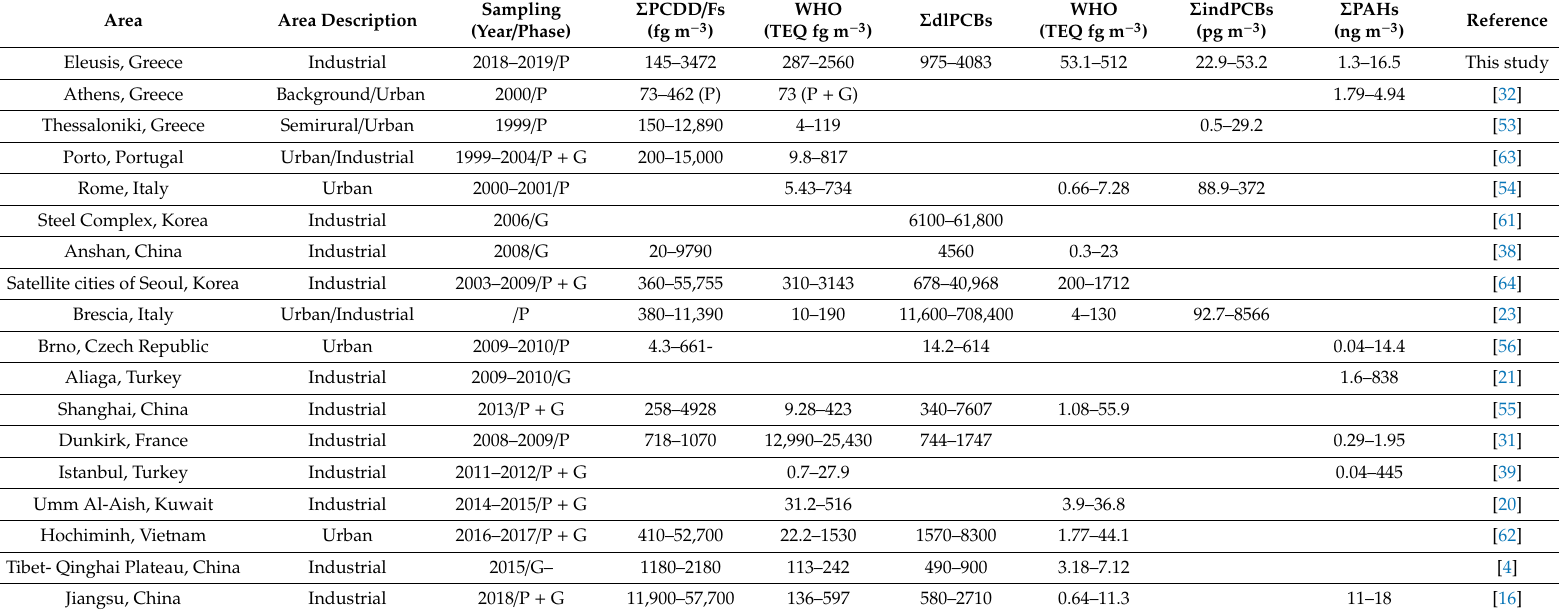
Table 5. Worldwide concentrations of persistent organic pollutants (POPs) according to literature in comparison with this study. ( p refers to particulate phase and G to gas phase